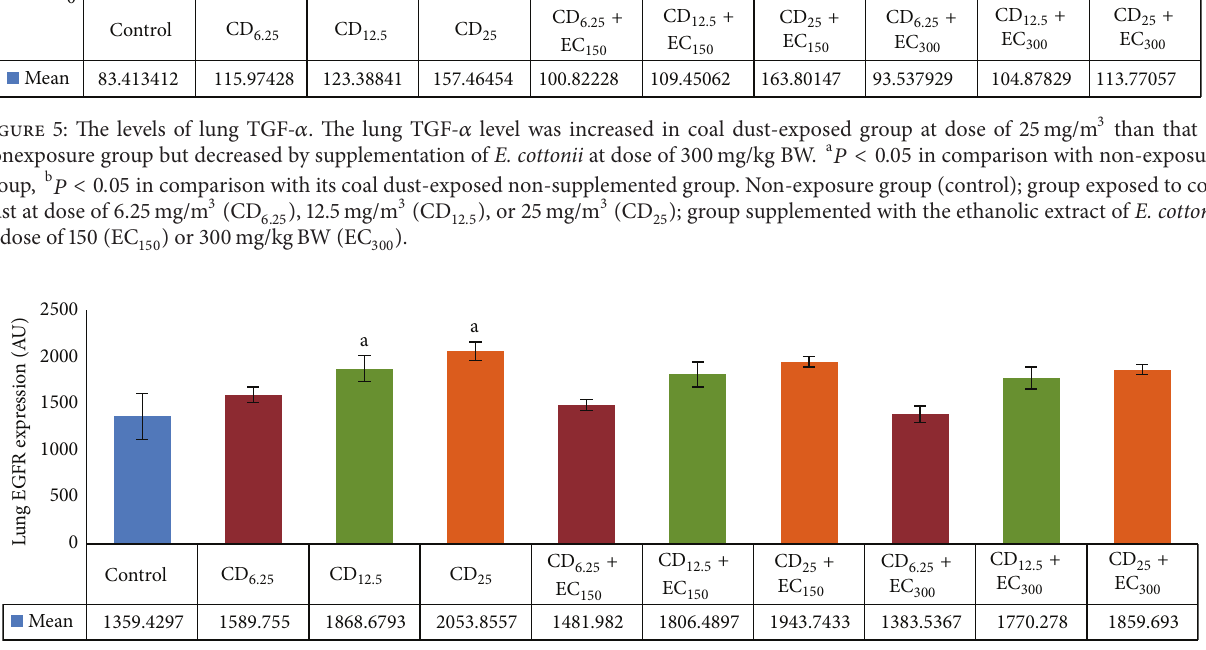
Figure6:TheexpressionsoflungEGFR.ThelungEGFRexpressionswereincreasedincoaldust-exposedgroupsatdosesof12.5and25 mg/m 3 than that in non-exposure group but decreased by supplementation of E. cottonii at dose of 300mg/kg BW. a 𝑃 < 0.05 in comparison with non-exposure group, b 𝑃 < 0.05 in comparison with its coal dust-exposed non-supplemented group. Non-exposure group (control); group exposed to coal dust at dose of 6.25 mg/m 3 (CD 6.25 ), 12.5mg/m 3 (CD 12.5 ), or 25 mg/m 3 (CD 25 ); group supplemented with the ethanolic extract of E. cottonii at dose of 150 (EC 150 ) or 300 mg/kgBW (EC 300